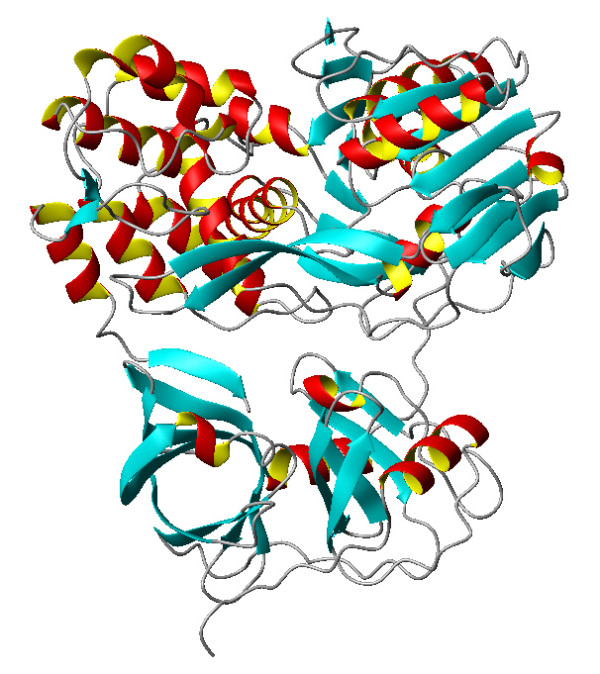
The strucuture of NS3 protease without inhibitor. The structure of NS3 protease variant, an engineered molecule that consists of 631 NS3 residues. It has six subdomains: two β barrels in the protease domain (down); two β-α-β subdomains (up on the left) and one α-helical subdomain in the helicase (up on the right). The figure was generated by Molmol [37].